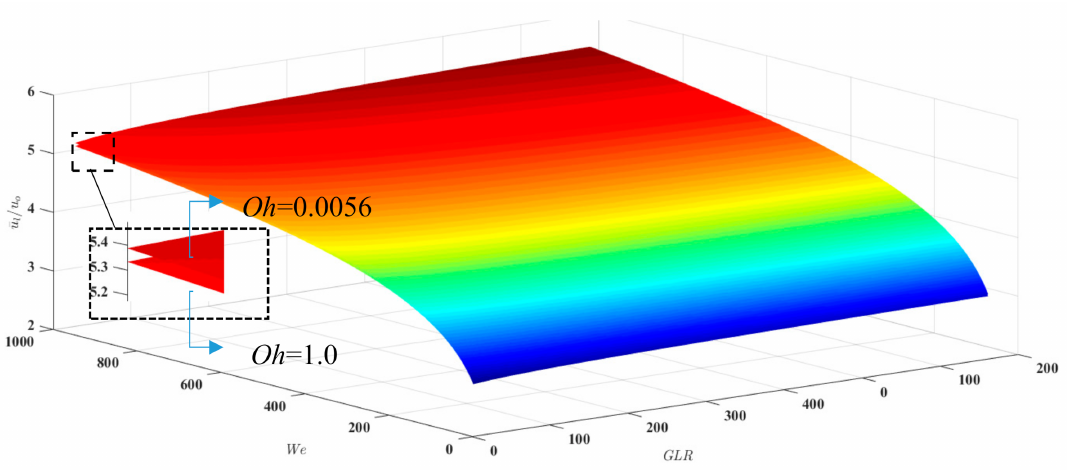
Figure 10. Three-dimensional response plot of ¯u l / u o as a function of We and GLR for Oh = 0.0056 and Oh = 1 at x / d g ~30. A zoom in box is provided to observe the di ff erence in